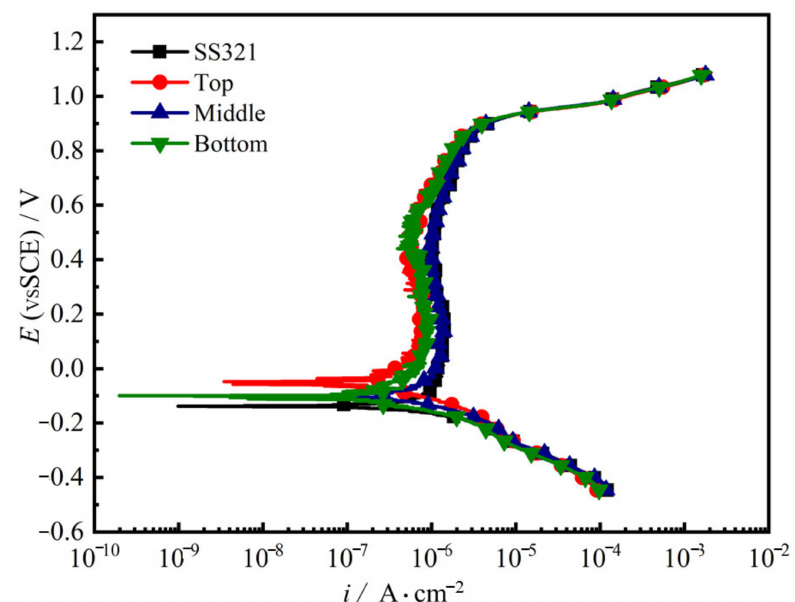
Figure 7. Potentiodynamic polarization curves of samples in 0.5 mol H 2 SO 4